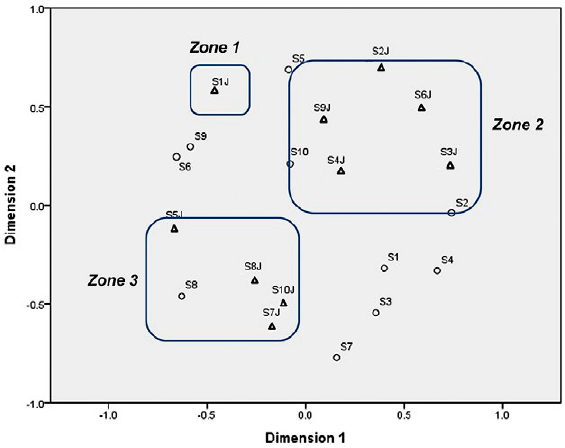
Fig. 5. – Two-dimensional plots of MDS analysis of DGGE pat- terns to compare broad-scale differences between cyanobacterial communities. S1-S10 represents samples in wet season; S1J-S10J represents samples in dry season.